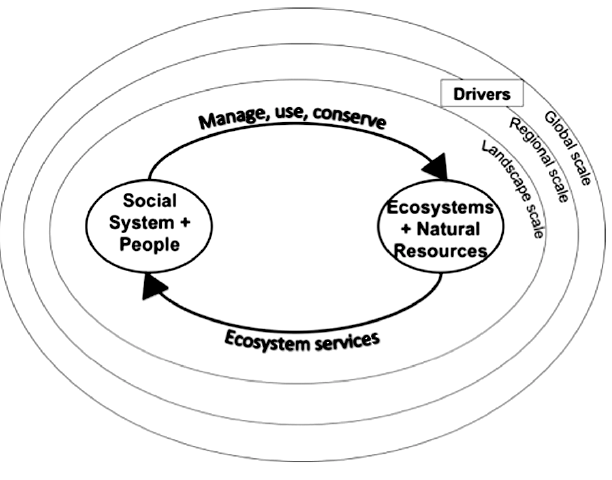
Fig. 1 . Conceptual model of reciprocal relationships between people and their environment (adapted from Fischer et al.